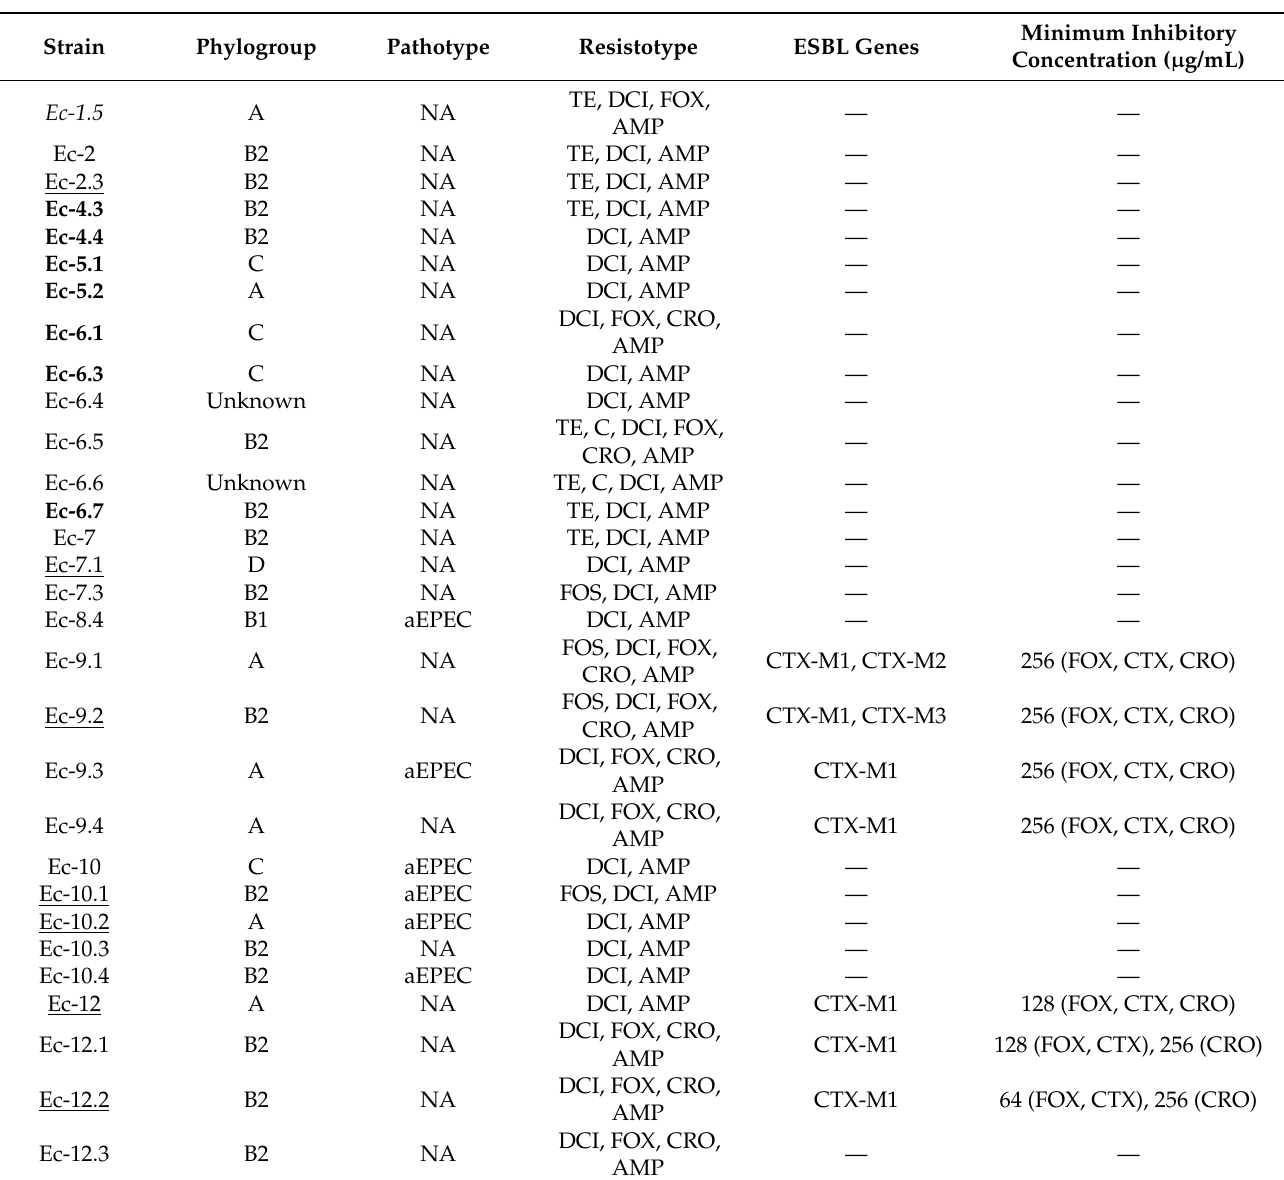
Table 1. Characteristics of strains isolated in this